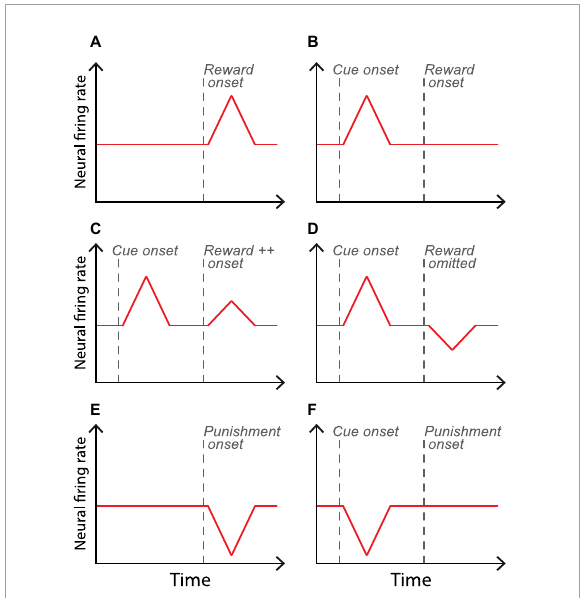
FIGURE1 Schematic midbrain dopaminergic neural responses of the encoding of reward prediction errors. Panels (A,B) represent neural activity in appetitive contexts where the reward delivery is unexpected (A) or predicted by a cue and thus expected (B) . Panels (C,D) represent firing rates when reward delivery is, respectively, above and below reward expectation. Panels (E,F) represent the firing rates of a neuron in aversive contexts where the punishment delivery is unexpected and expected,